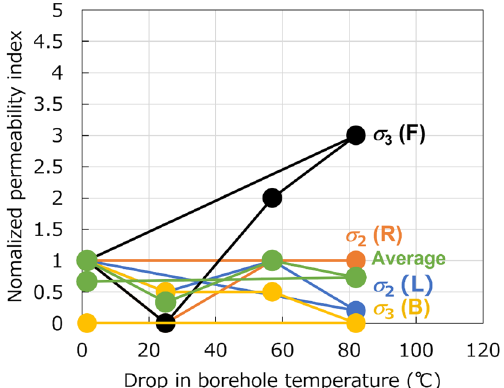
Fig. 7 Relationship between the normalized permeability index and drop in borehole temperature for each direction in Run 2. σ x (y) denotes the outlet face, y (R: right face, L: left face, F: front face, B: back face) subjected to the principal stress, σ x (x: 1, 2, 3)